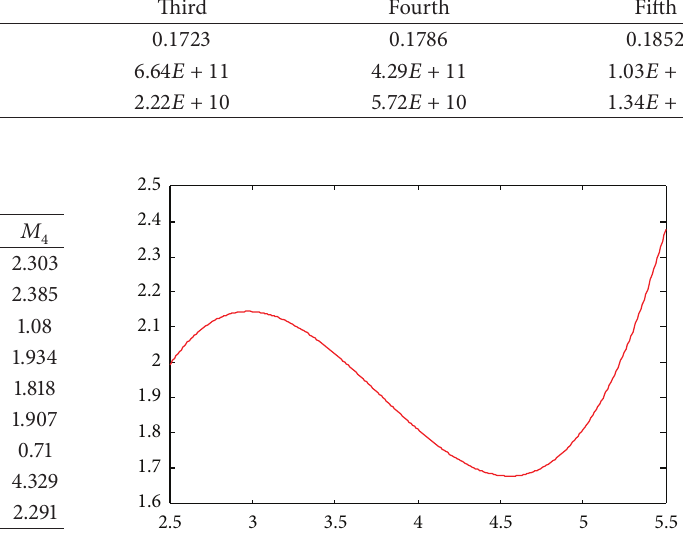
Figure 2: The diagram of Malmquist product index DMU 2 .